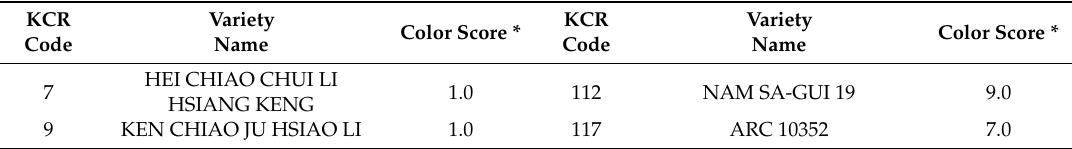
Figure 5. Frequency distribution of leaf color score of varieties under the cold stress condition. 202 Numbers in the top of each column indicate the average leaf color score in each group. 203